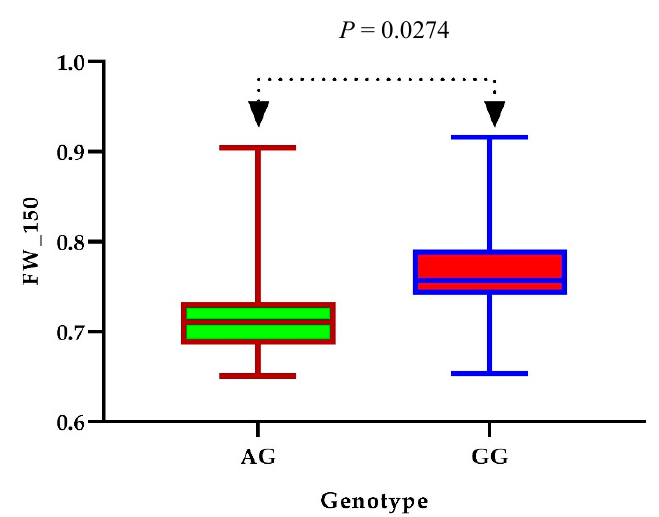
Figure 6. Difference of FW_150 between two haplotypes. In the box plot, the center line shows the median, the box limits are the upper and lower quartiles, and the whisker depicts the range of the data; n shows the number of accessions with the same genotype. Significance of difference ( p -value) was analyzed with a two-tailed t test.